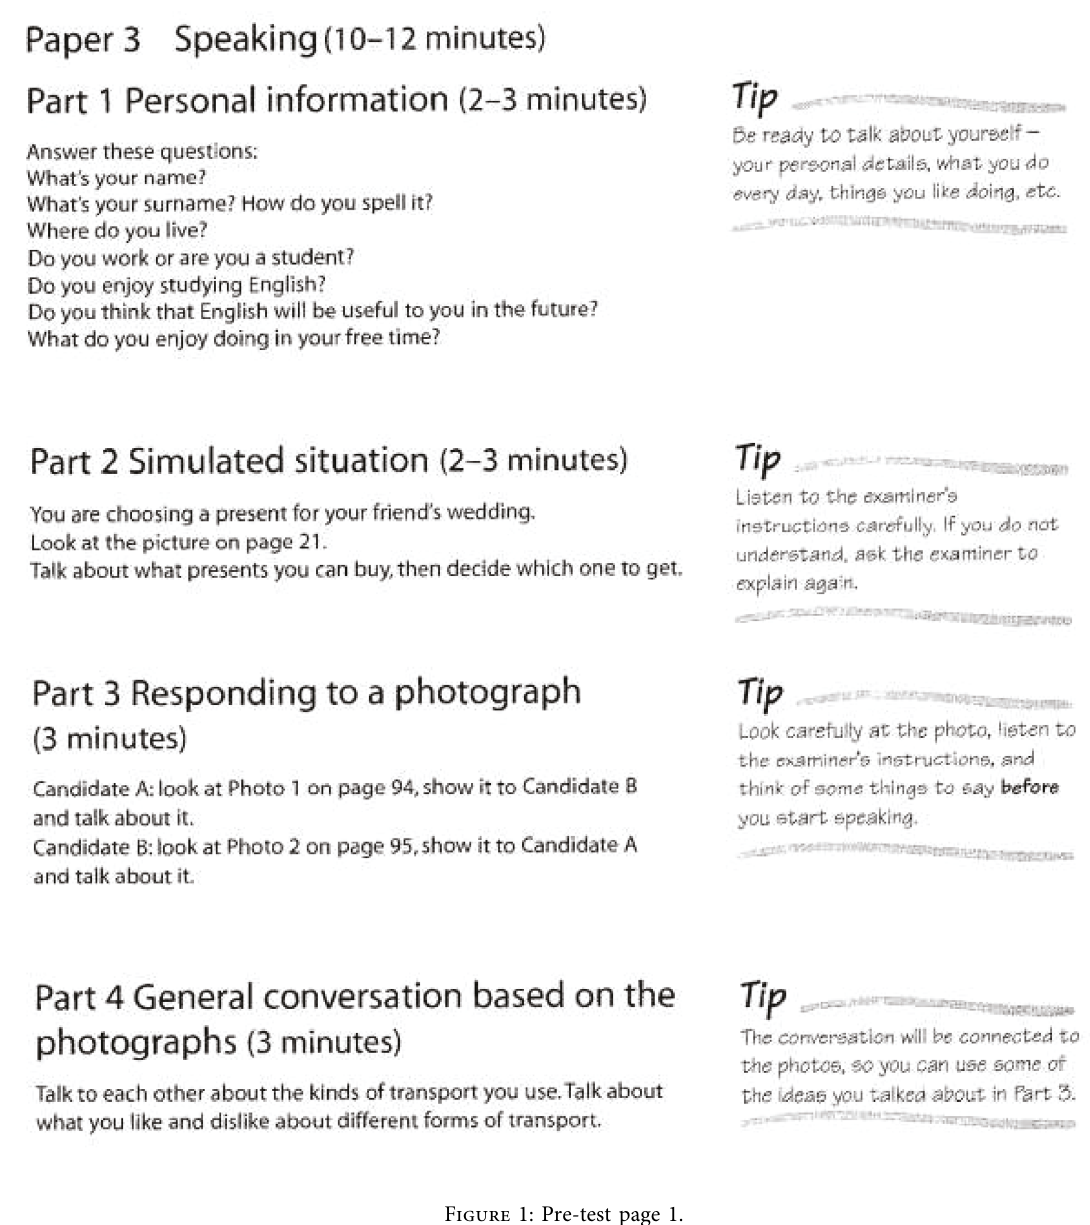
Figure 1: Pre-test page